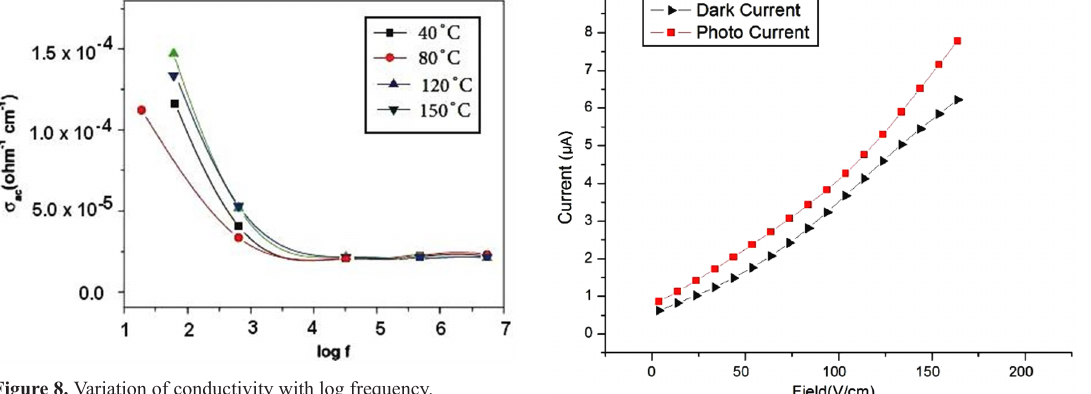
Figure 8. Variation of conductivity with log frequency.